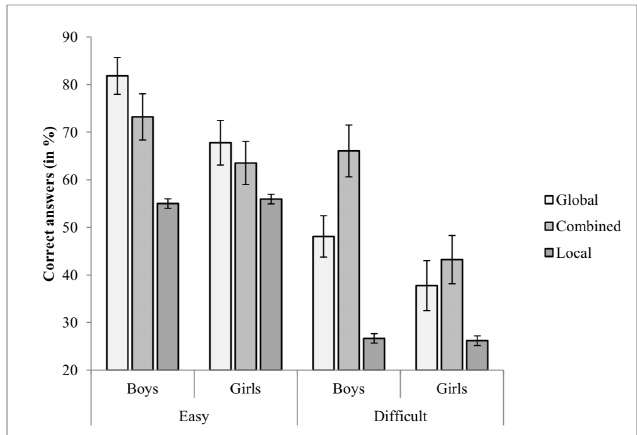
Figure 3. Percent of Correct Answers on the CWMR